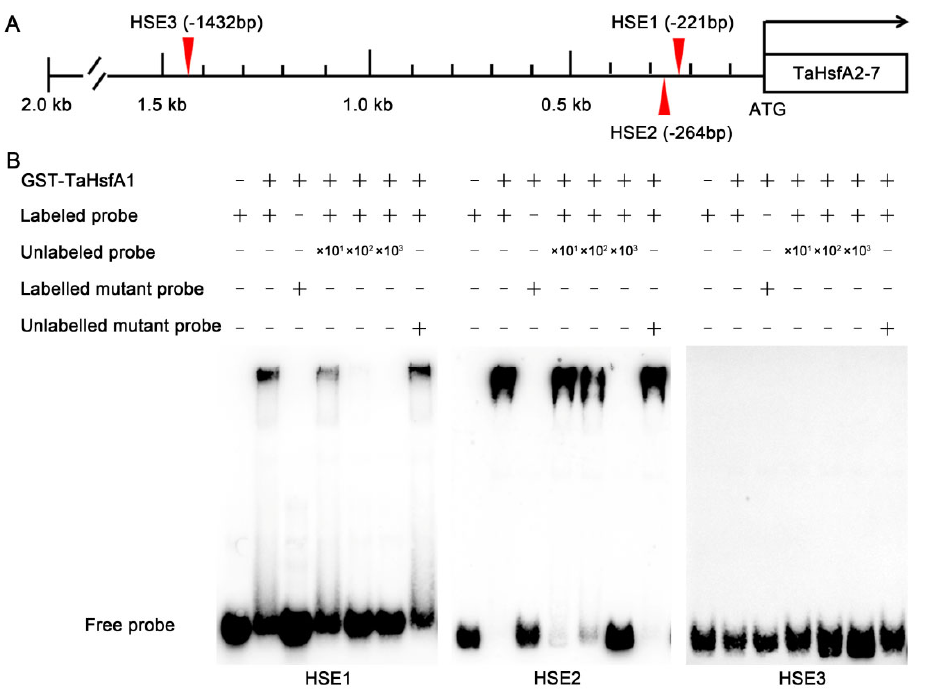
Figure 6. TaHsfA1 regulates the expression of TaHsfA2-7 and TaHSFA2-7-AS. ( A ) Diagram of the TaHsfA2-7 promoter. The cis -acting HSEs (HSE1, HSE2 and HSE3) in the promoter sequence of TaHsfA2-7 are marked with red triangles. ( B ) EMSA of TaHsfA1 binding to the cis-acting HSEs (HSE1, HSE2 and HSE3) in the TaHsfA2-7 promoter. Biotin-labeled probe containing the cis -acting HSEs (HSE1, HSE2 and HSE3) from TaHsfA2-7 promoter was incubated with GST-TaHsfA1 in vitro. An unlabeled probe or unlabeled mutated probe was used for competition and the biotin-labeled mutated probe was used as negative control.